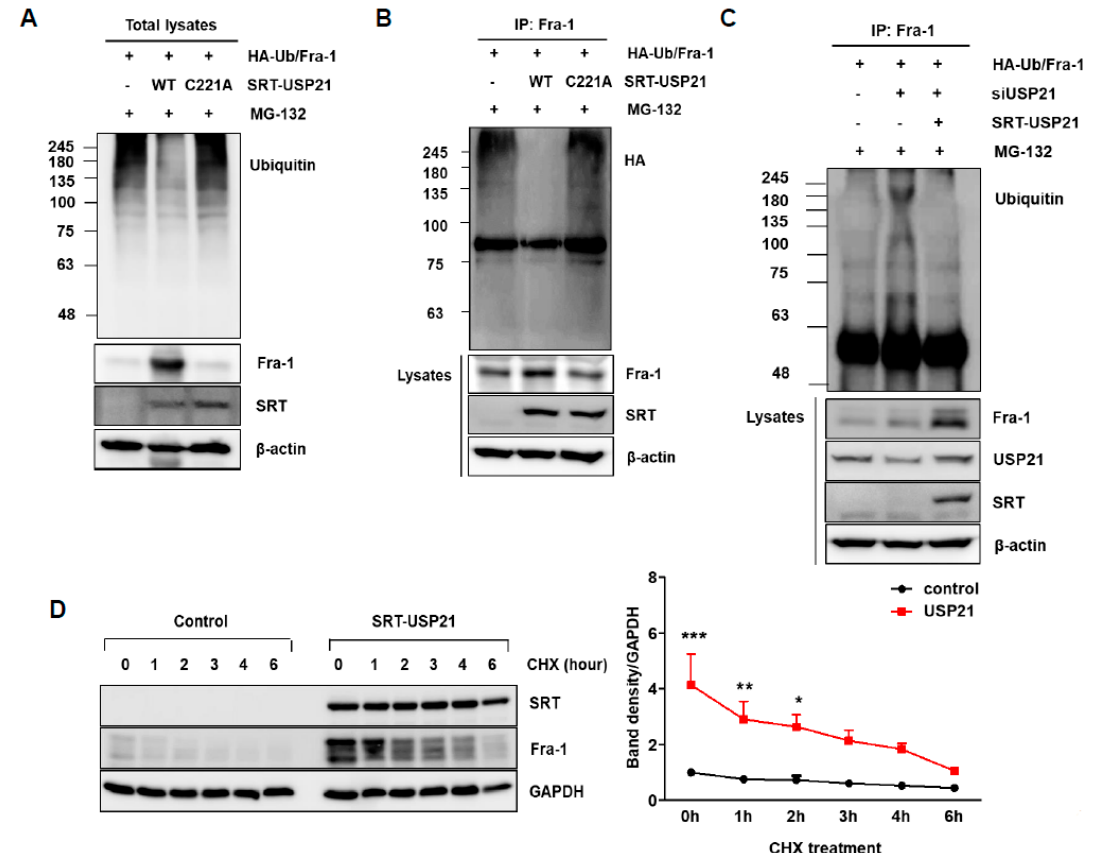
Figure 3. USP21 regulates degradation of Fra-1 protein. ( A – C ) To determine Fra-1 ubiquitination,